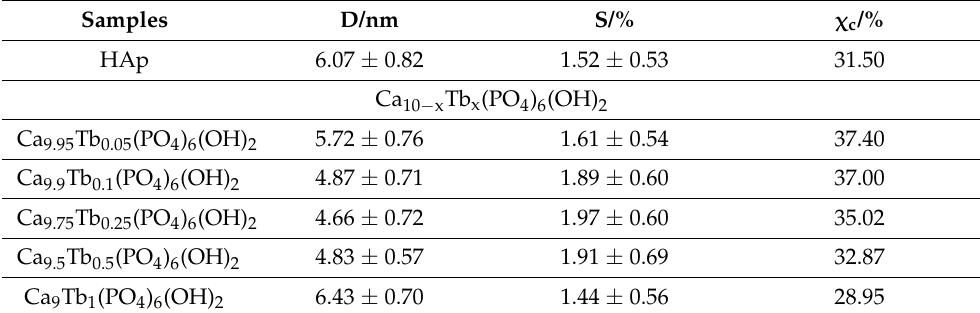
Table 2. Calculated crystallite size (D) values and degree of crystallinity ( χ c ) of pure HAp and terbium-doped hydroxy- apatite with various concentrations.